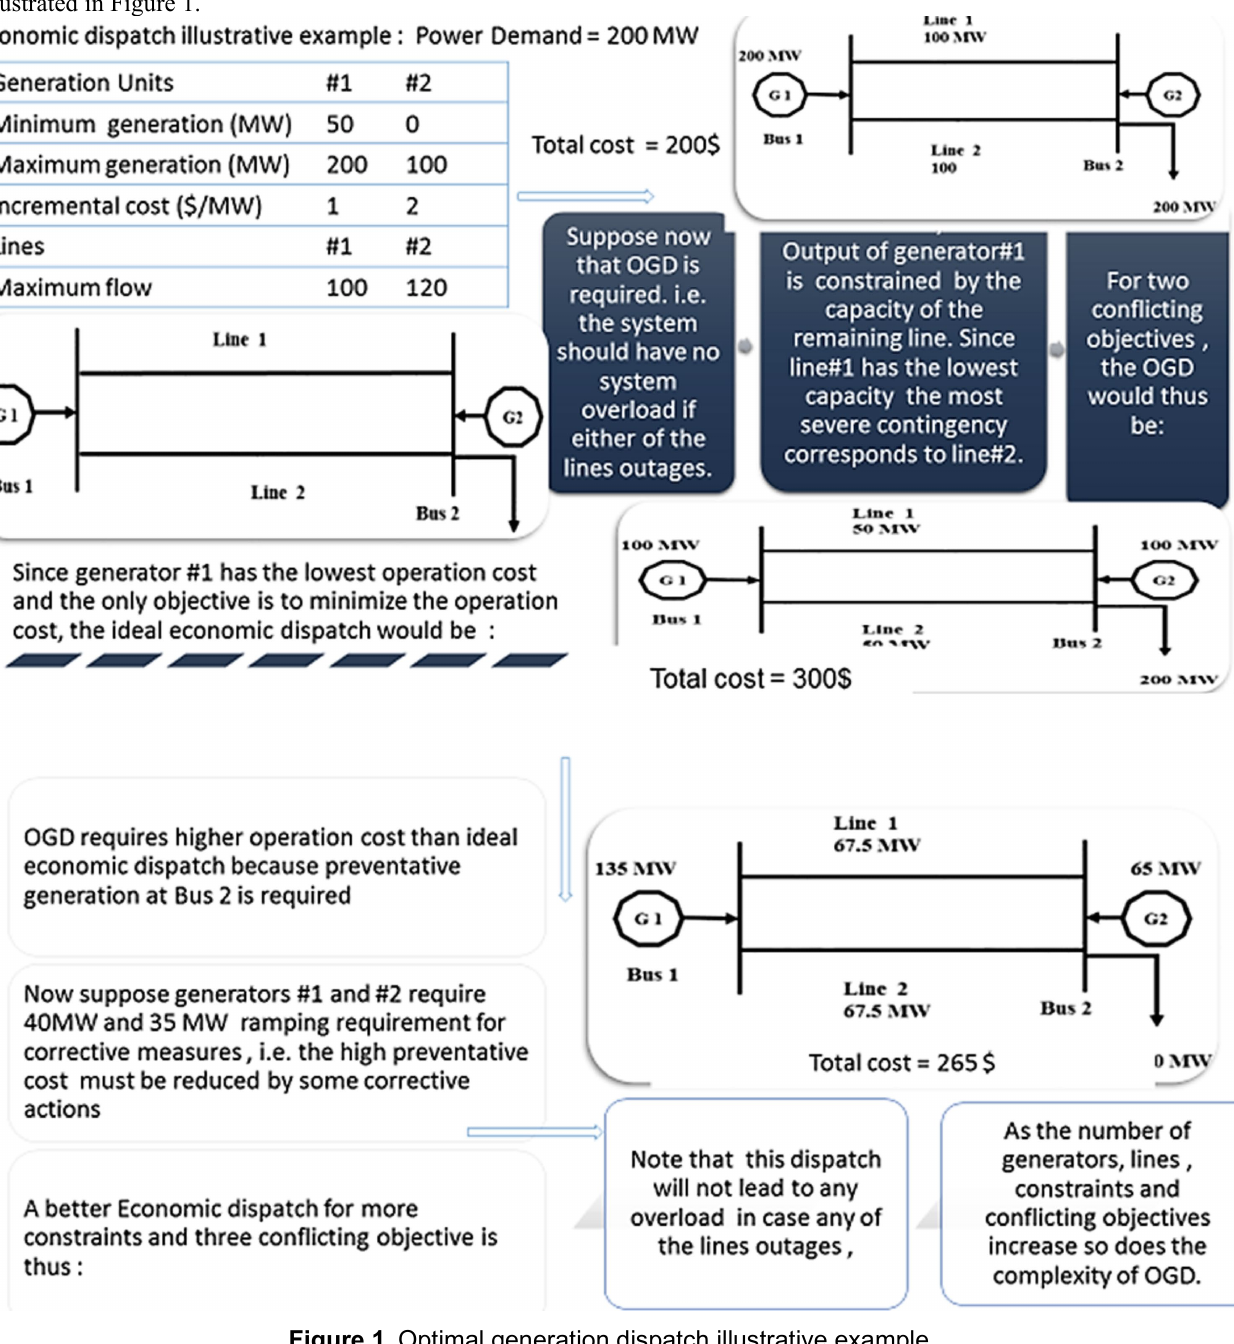
Figure 1. Optimal generation dispatch illustrative